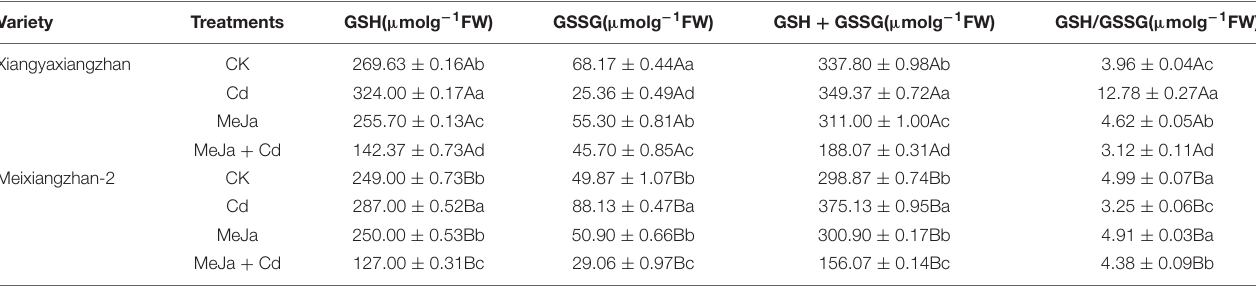
The values are representative of three replicated means per treatment ± SE. Different letters indicate significant differences between cultivars and treatments at p < 0.05, LSD. CK, control (normal conditions); Cd,100 mg Cd kg − 1 of soil; MeJa, exogenous application of MeJa at 20 mM; and Cd + MeJa, 100 mg Cd kg − 1 of soil + exogenous MeJa application at 20 mM. TABLE 6 | The effects of exogenous MeJa application on malondialdehyde (MDA), H 2 O 2 , and electrolyte leakage (EL) in two fragrant rice cultivars under Cd stress. Variety